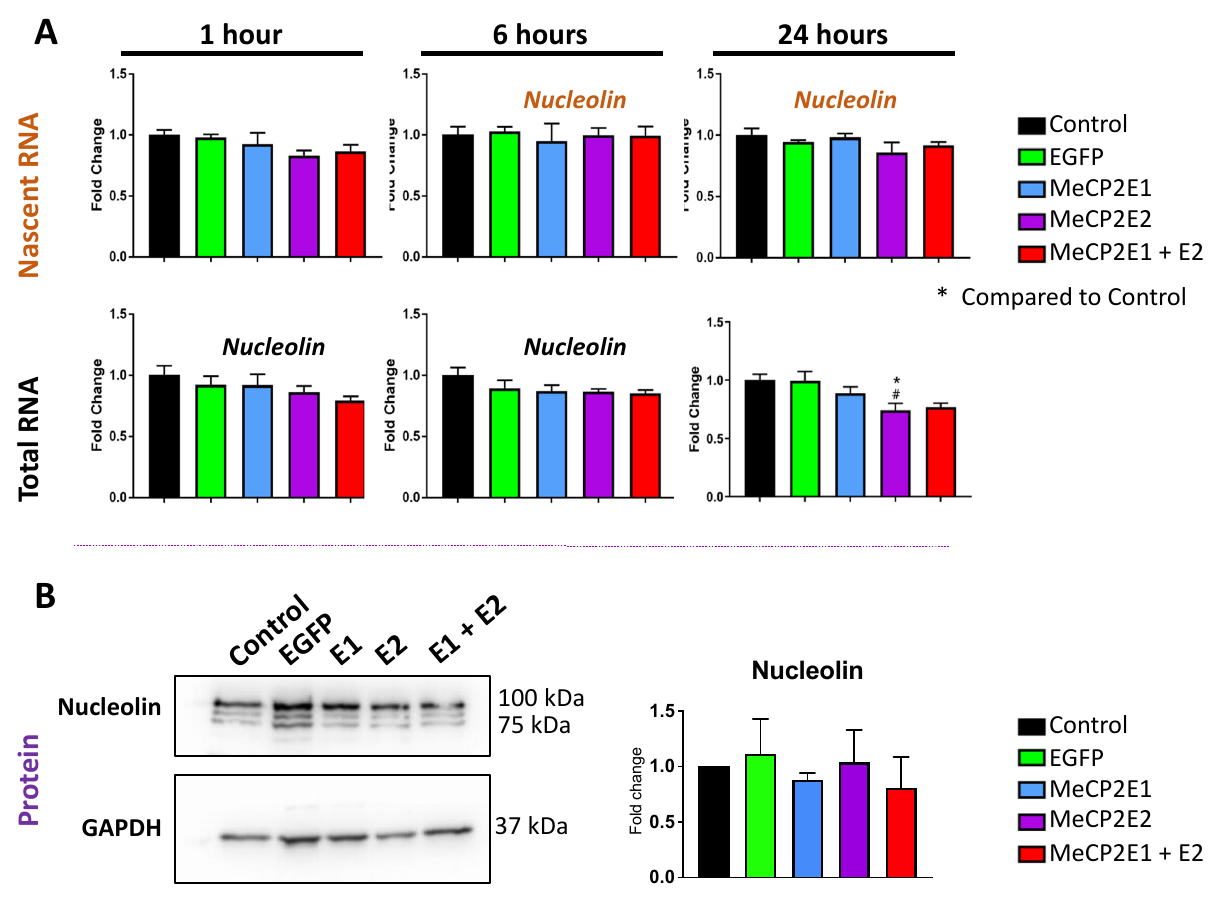
Figure 7. Expression of the nascent and steady-state Nucleolin transcripts and Nucleolin protein in Daoy cells transduced with lentiviral vectors expressing MeCP2 isoforms. ( A ) Nascent RNA was prepared from cells labelled with EU for 1 h, 6 h, and 24 h. Total RNA was also prepared from unlabeled cells collected at the same time points. Gene expression was analyzed by RT-PCR for